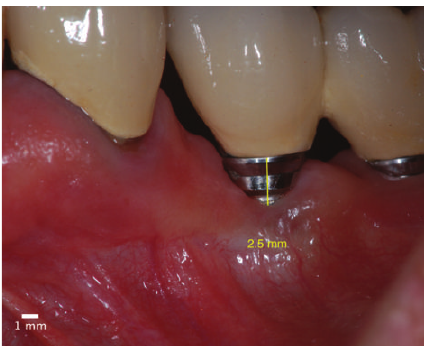
Figure 21: Two years after the surgery. Covering almost all of the threads of the implant due to the phenomenon of “creeping